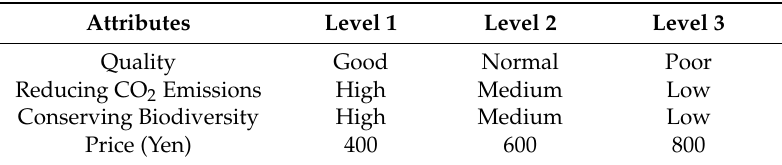
Table 1. Attributes and attribute levels in CE